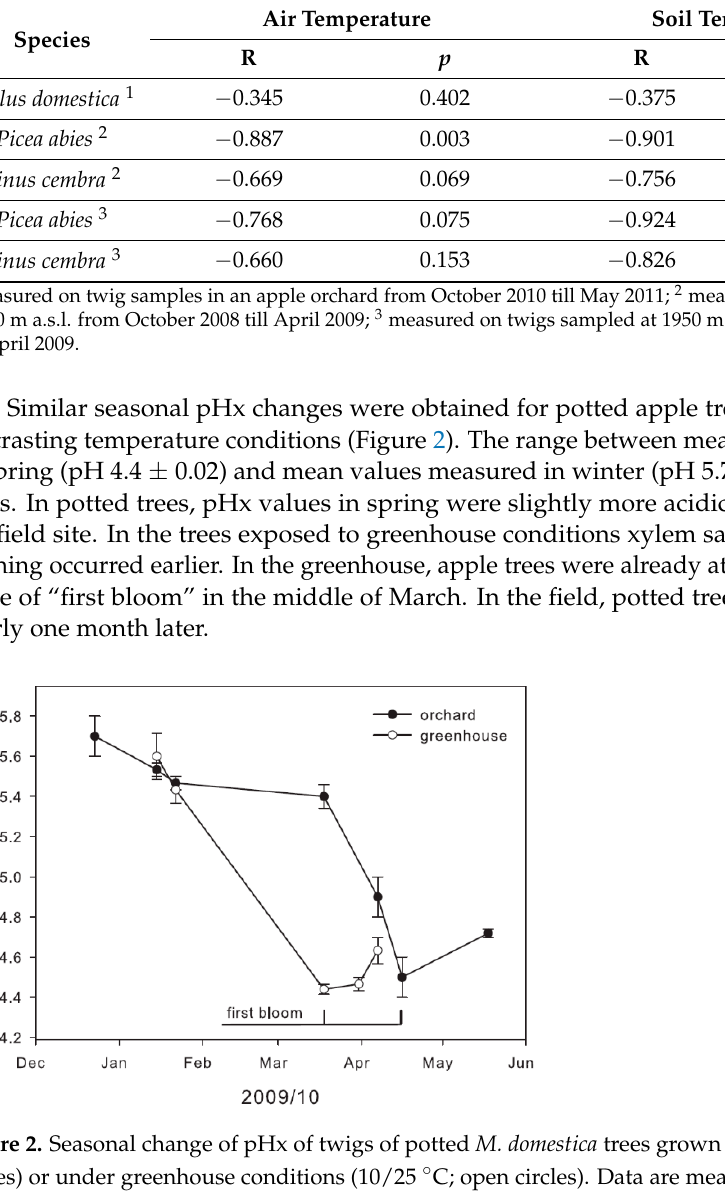
Table 1. Effect of air and soil temperatures (mean values from 7 days before sampling) on pHx (mean values, n = 5). The Pearson correlation coefficient (r) is given for calculations obtained with data from eight different sampling dates.